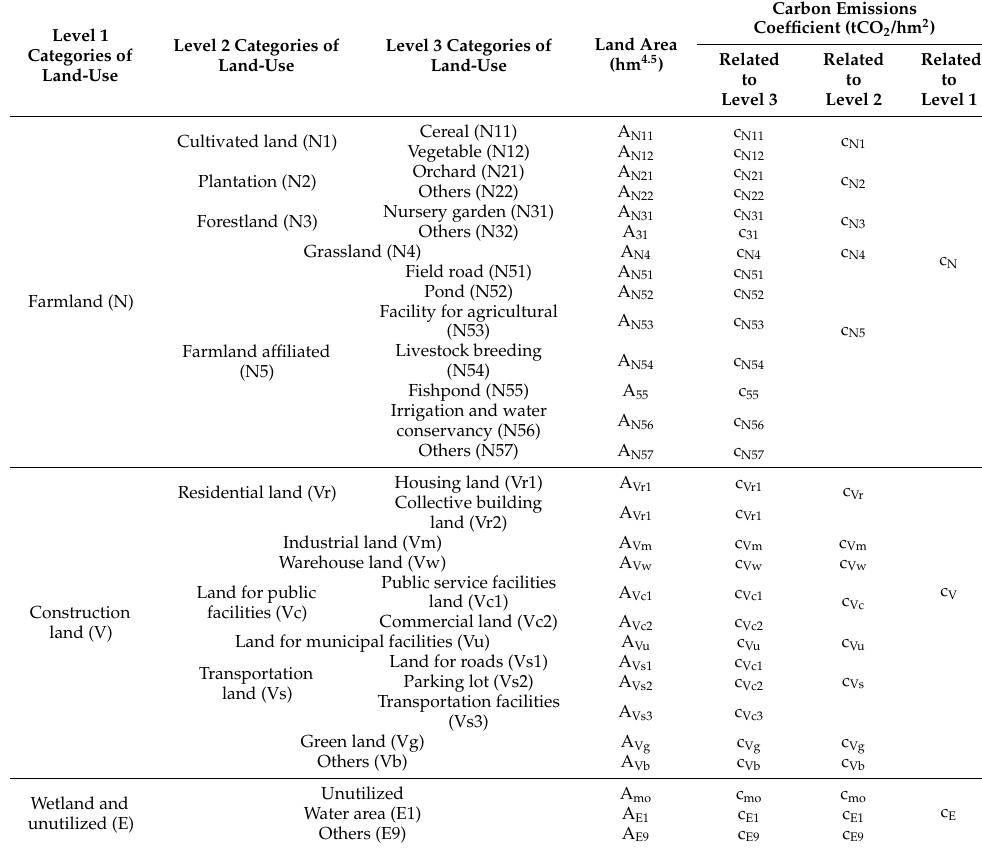
Table 2. Carbon emissions indicators associated with land-use classifications.